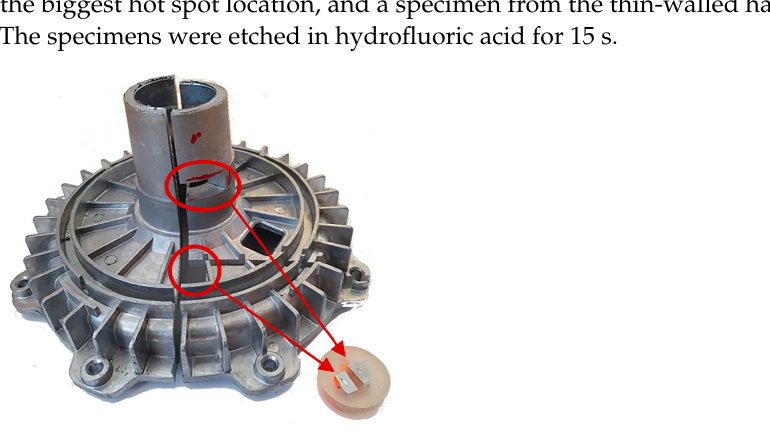
Figure 7. SB 55 casting with extracted specimens from both hat and tube parts.